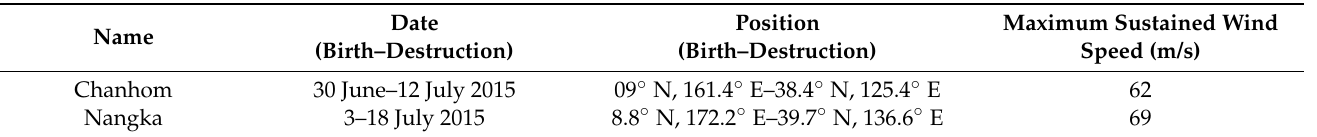
Table 2. Information regarding typhoons Chanhom and Nangka (from the Joint Typhoon Warning Center (JTWC)